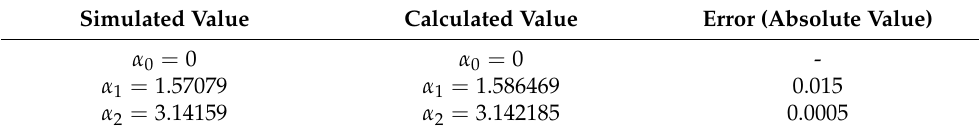
Figure 5. Front panel of LabView for the implemented algorithm with simulated interferograms: ( a ) simulated pattern without phase shift, ( b ) simulated pattern with phase shift of π /2 rad, ( c ) simulated pattern with phase shift of π rad, ( d ) calculated wrapped phase function, ( e ) original 2D phase function, ( f ) recovered (unwrapped) 2D phase function, ( g ) difference between the original and the recovered phase, and ( h ) recovered 3D phase plot. Table 1. Comparison between the simulated and the calculated values for the phase shifts.